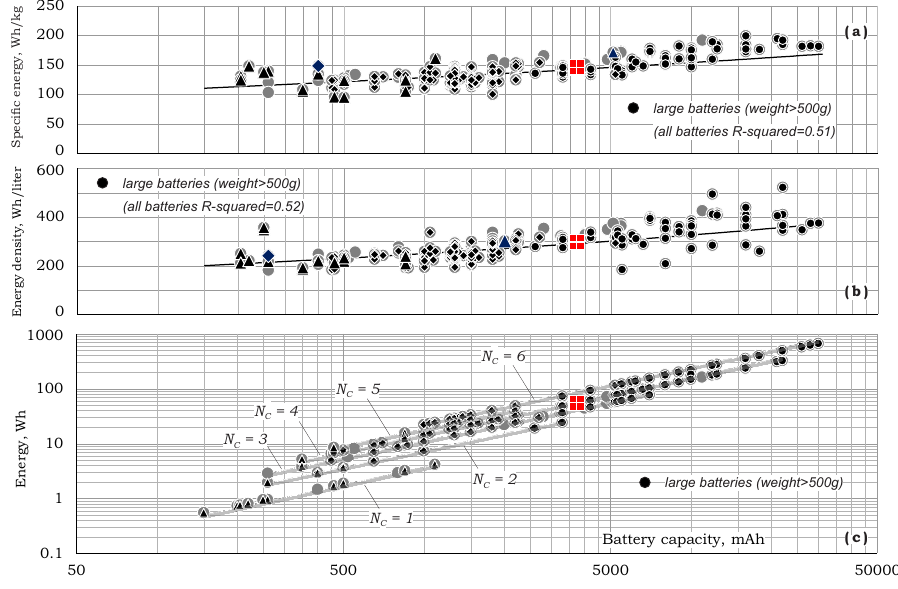
Figure 14. Battery parameters design trends (cont.),